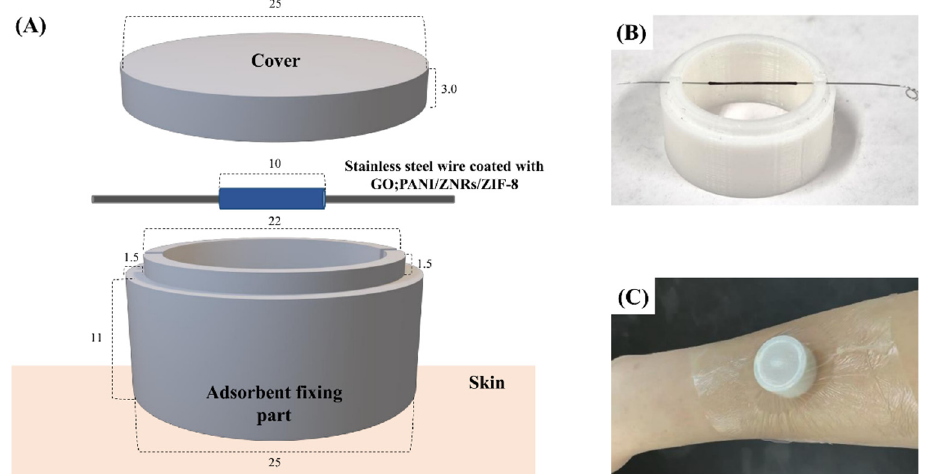
Figure 3. ( A ) A schematic view of adsorption kit for the collection of body odor from human skin (the unit of length: mm). ( B ) Actual image of adsorbent placed on the fixing part made by 3D printer. ( C ) Sampling of body odor at the arm using adsorbent kit covered by a medical tape.